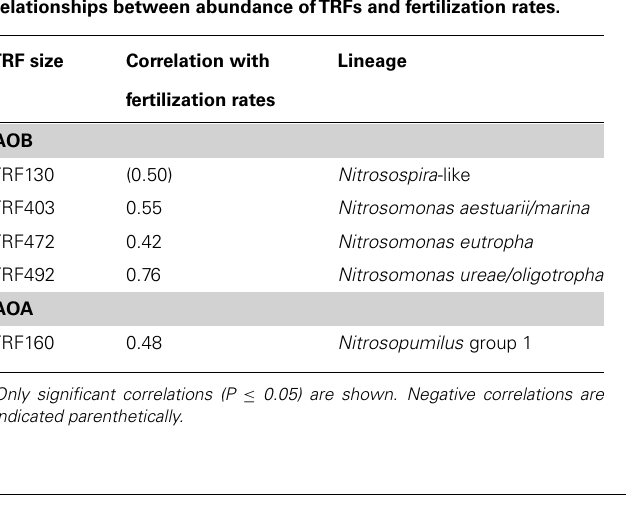
Table 1 | Pearson’s correlation coefficients ( r ) describing the relationships between abundance ofTRFs and fertilization rates.